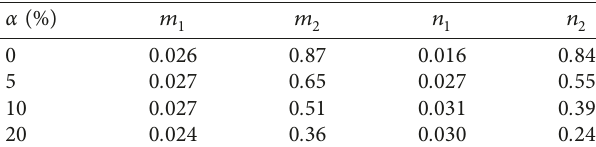
Table 1: Coefficients for calculating equivalent period and damping [18].